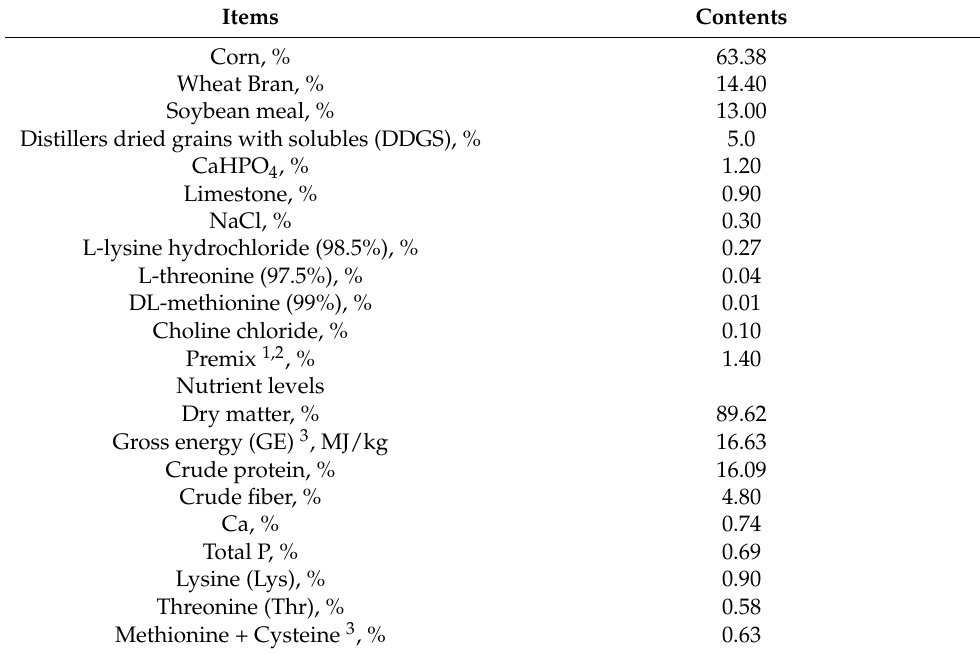
Table 1. Basic diet composition and nutrient level (air-dry